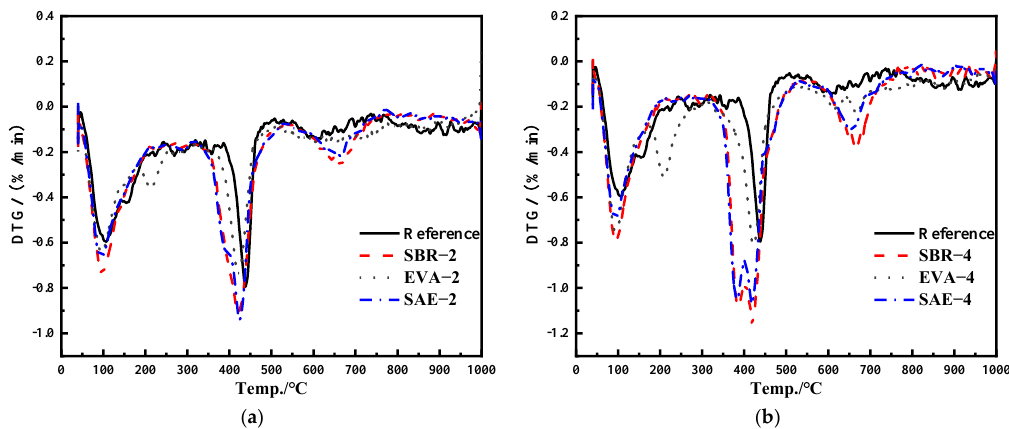
Figure 7. DTG curves of paste samples with different polymer latex types and contents at 28 days: ( a ) polymer–cement ratio is 6%; ( b ) polymer–cement ratio is 12%.